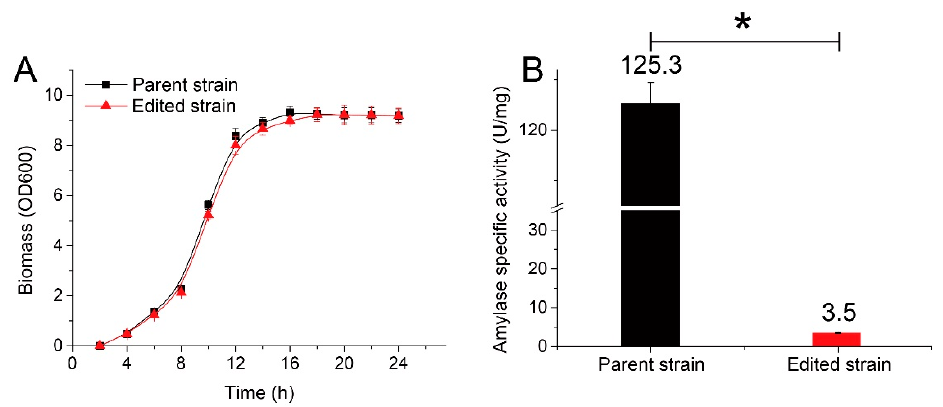
Figure 4. Growth curves of the parent B. licheniformis and the edited strain with a disrupted amyL gene ( A ) and their extracellular amylase activities after fermentation ( B ). Luria-Bertani (LB) broth was inoculated with 1% of the culture and incubated at 37 °C with shaking at 250 rpm. Bars with * represent statistically significant differences between groups at p < 0.01 ( n = 3).